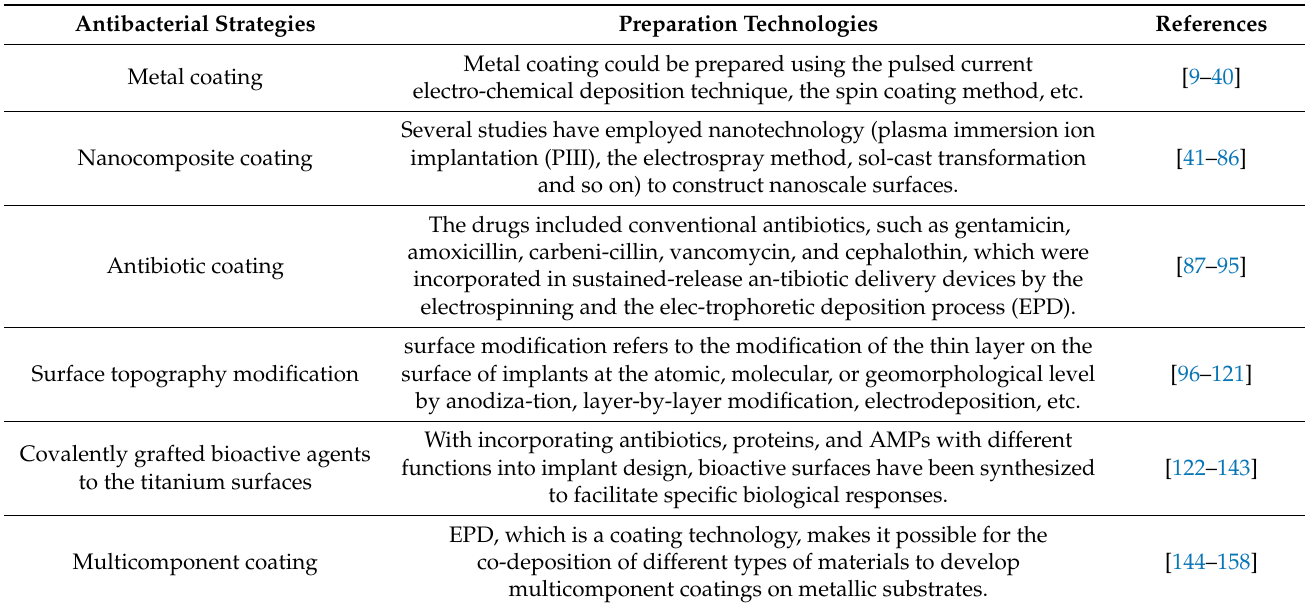
Table 1. Antibacterial strategies and preparation